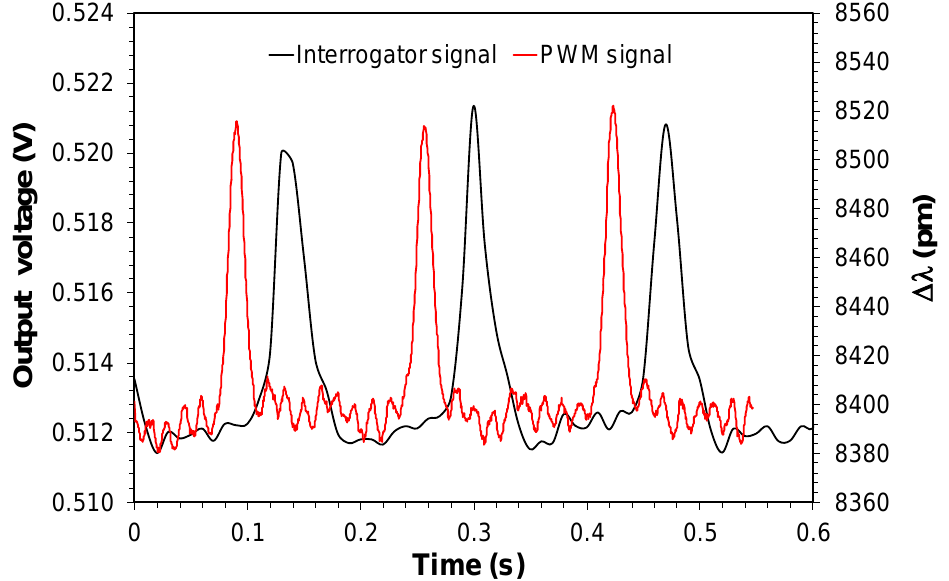
Figure 12. Dynamical curves of FBG pressure sensor in the monitoring point of engine combustion obtained by the PWM demodulator and the interrogator.